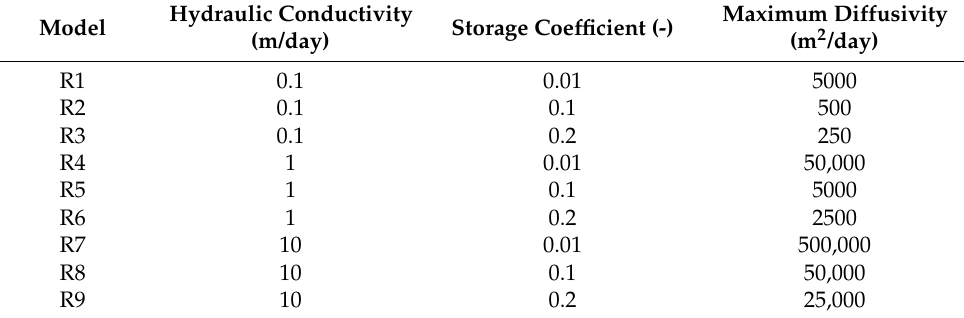
Table 1. Model aquifer properties.